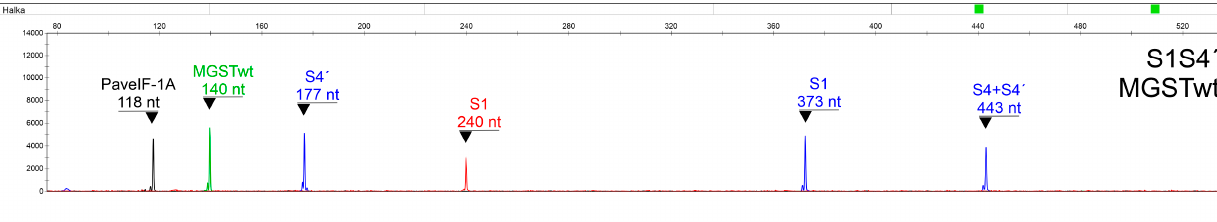
Figure 3. A representative output of fragment analysis in the ‘Halka’ cultivar (S1S4 ′ ; MGSTwt). Finally, matrices for the clear interpretation of fi ndings were created—each allele is represented by a unique (combination of) fragment(s) (Table 2), and each fragment is as- sociated with a particular allele(s) (Table 3). Table 3. A fragment association with a particular MGST-, S-allele, and the PaveIF-1A control. * Con- fi rmation of the particular S-allele by another fragment. ** According to the alignment of GenBank sequences DQ266445 for S14 and AY259114 for S23, there are only three nucleotides di ff erent, and all of them lie in introns. As the S-RNase protein will be the same for both S-alleles, distinguishing these alleles was not a priority of this study.